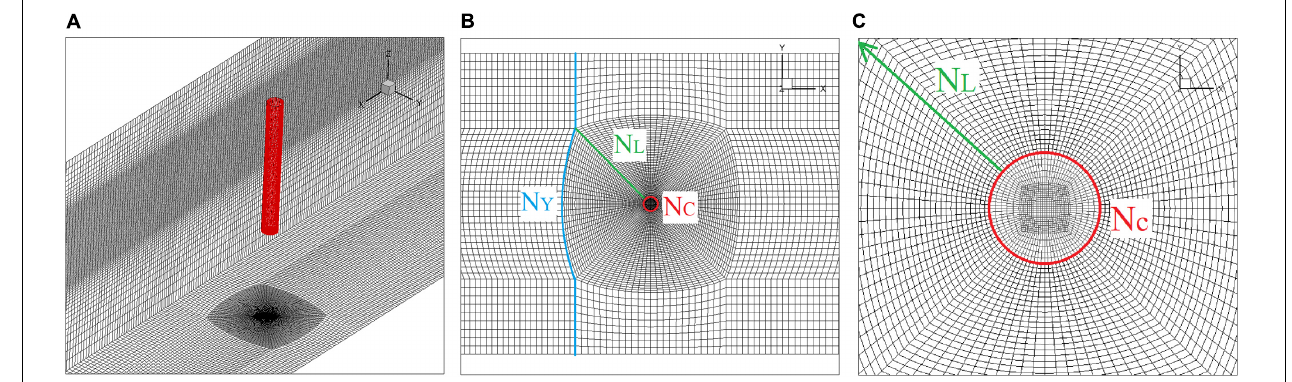
FIGURE 6 | Overall and detailed mesh arrangements. (A) Global mesh, (B) local mesh around the cylinder, and (C) zoomed local mesh.